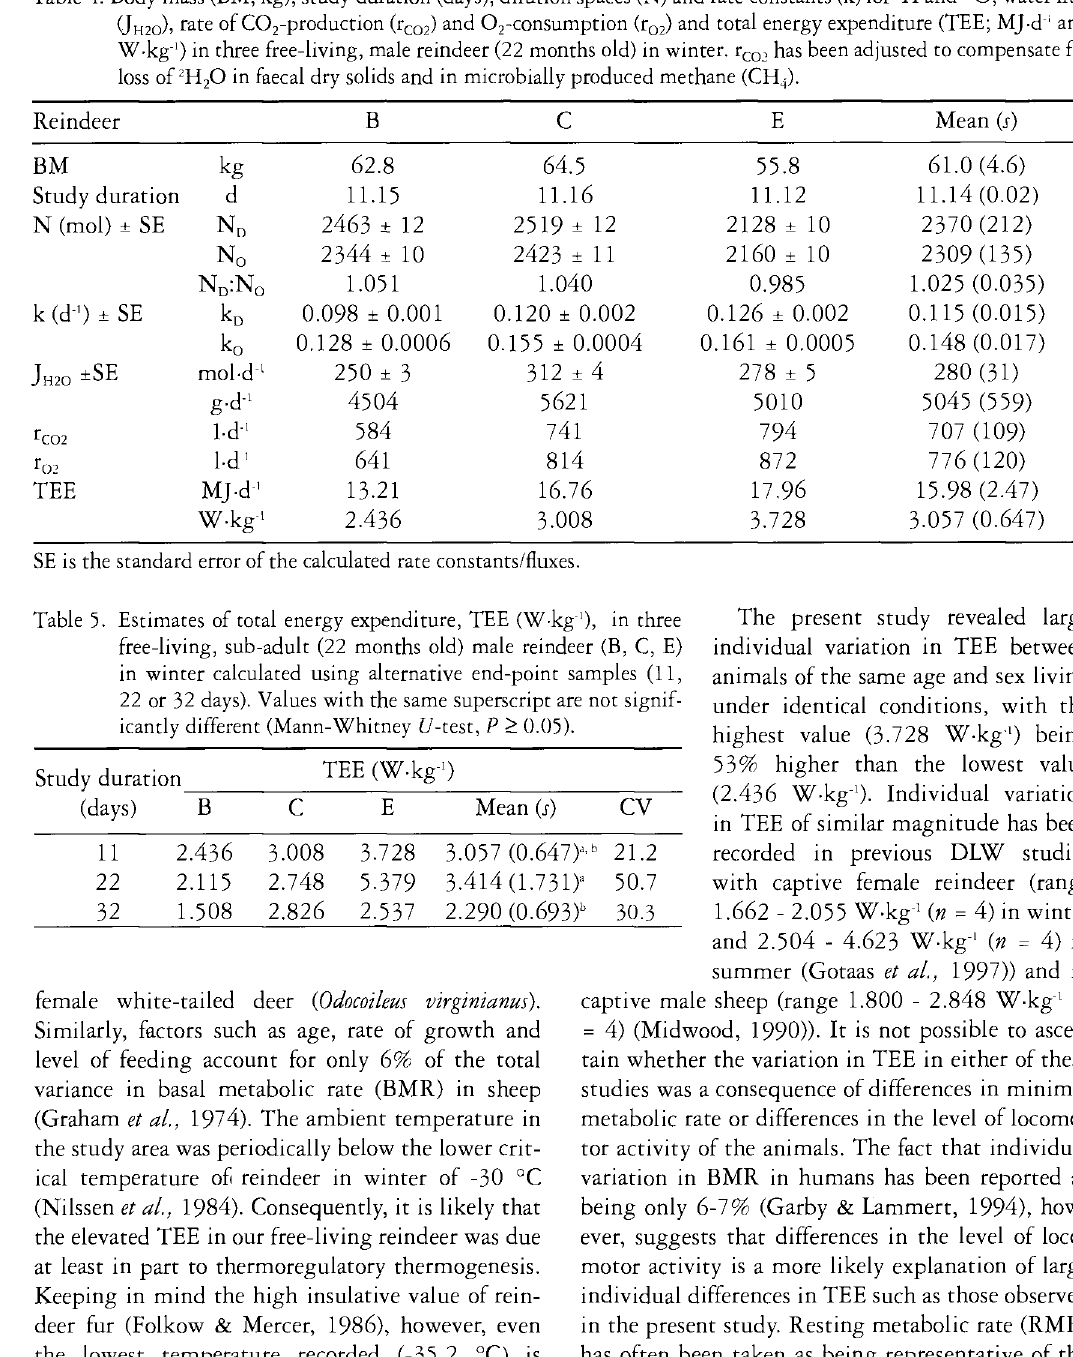
Table 4. Body mass (BM; kg), study duration (days), dilution spaces (N) and rate constants (k) for 2 H and ls O, water flux (J ), rate of C0 -production (r ) and 0 -consumption (r ) and total energy expenditure (TEE; MJ-d 1 and H20 2 C02 2 02 W-kg ') in three free-living, male reindeer (22 months old) in winter. r has been adjusted to compensate for C02 loss of 2 H 0 in faecal dry solids and in microbially produced methane (CH ). 2 4